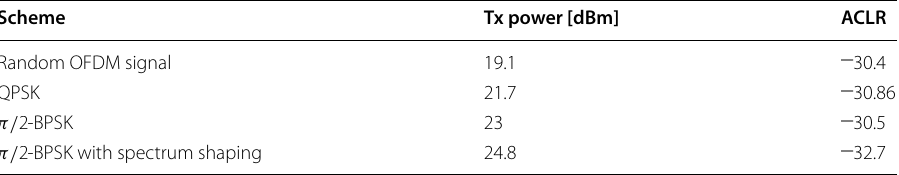
Table 2 Tx power and ACLR comparison for various modulation schemes [22]